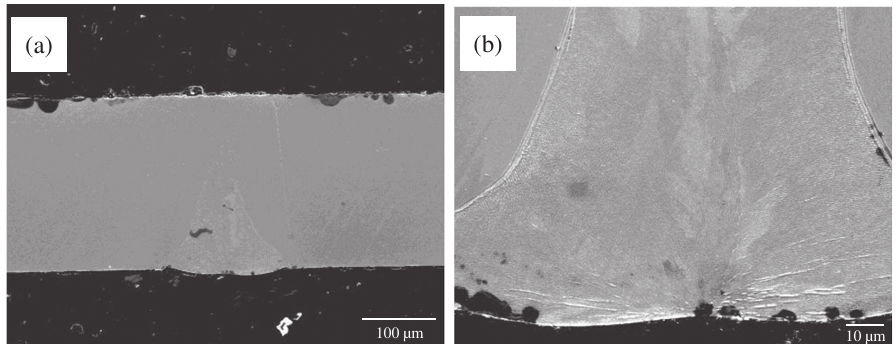
Figure 2: (a) The laser pulse with 50 mJ energy (100 W, 500 µs, focus þ 0 mm) (b) detail of the laser